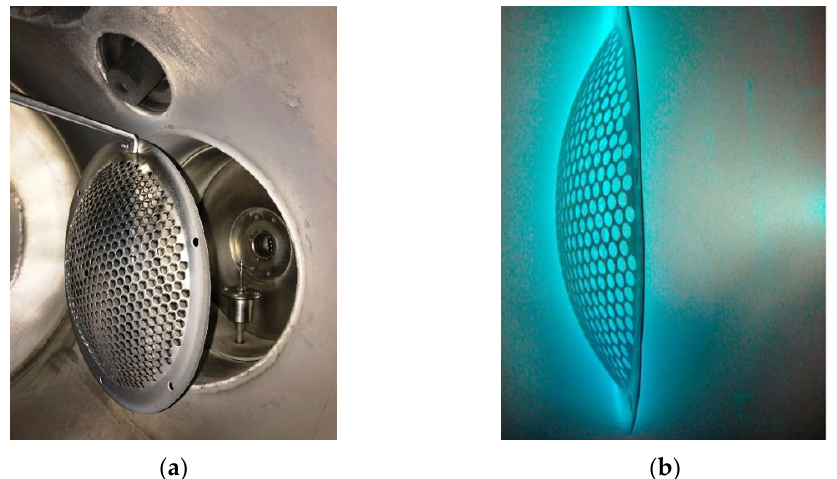
Figure 8. Photographs of the accelerating grid and 3-mm-diameter end mill on the rotating holder ( a )